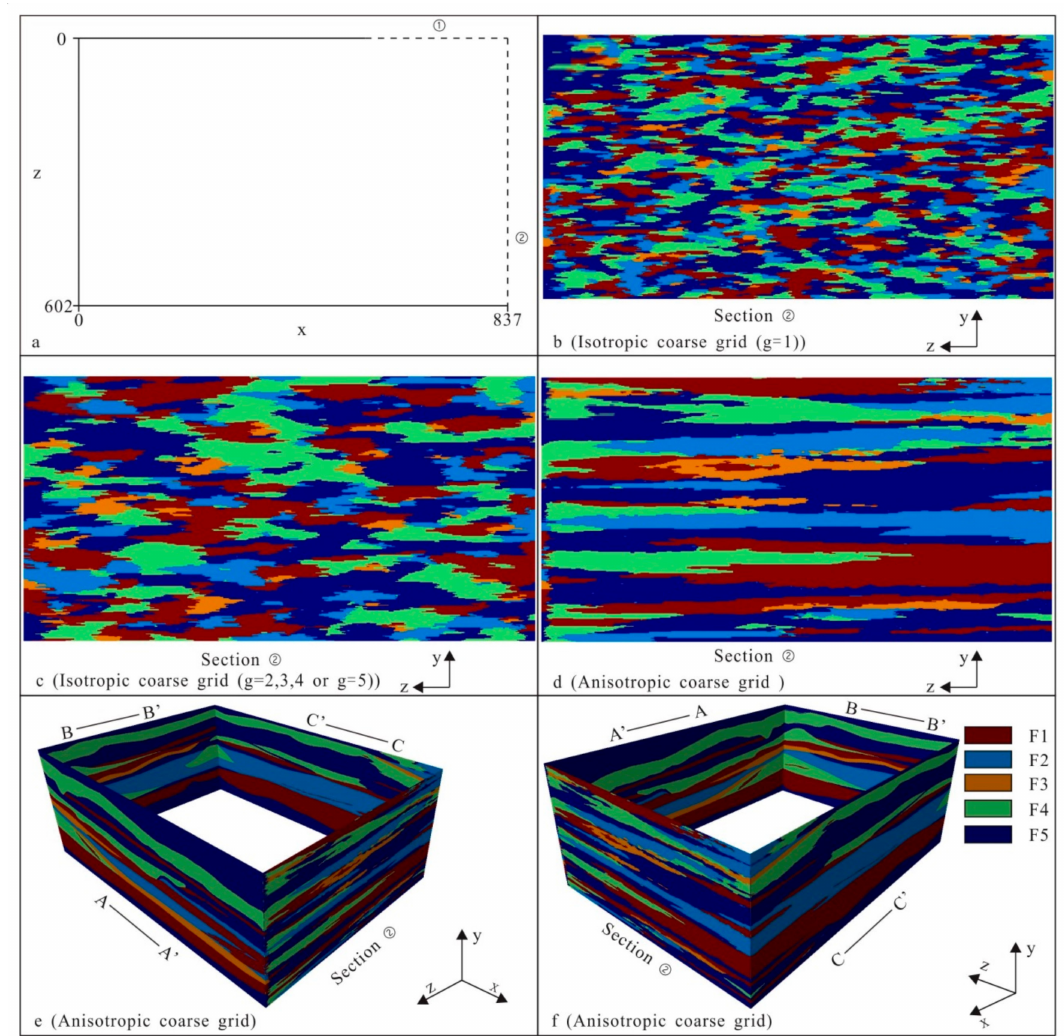
Figure 6. Results under di ff erent conditions. ( a ) The location of section (2); ( b ) the simulated results without multiple grids; ( c ) the simulated results with isotropic multiple grids (g = 2, 3, 4, 5); ( d – f ) the simulated results with anisotropic multiple